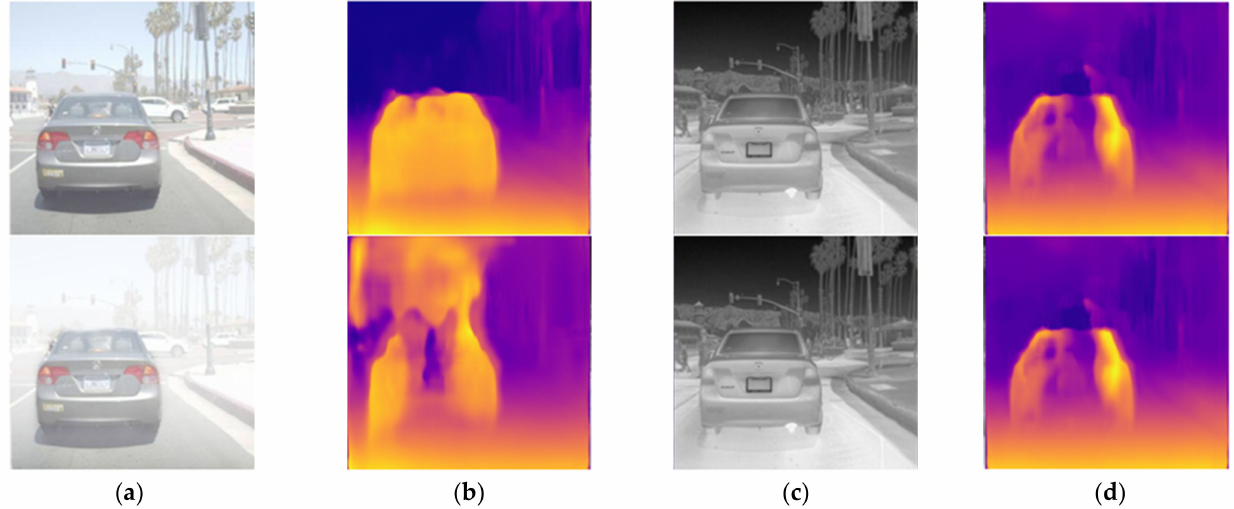
Figure 2. Examples of haze-free (top) and hazy (bottom) images: ( a ) RGB image, ( b ) depth map estimated from the RGB image, ( c ) thermal image, ( d ) depth map estimated from the thermal